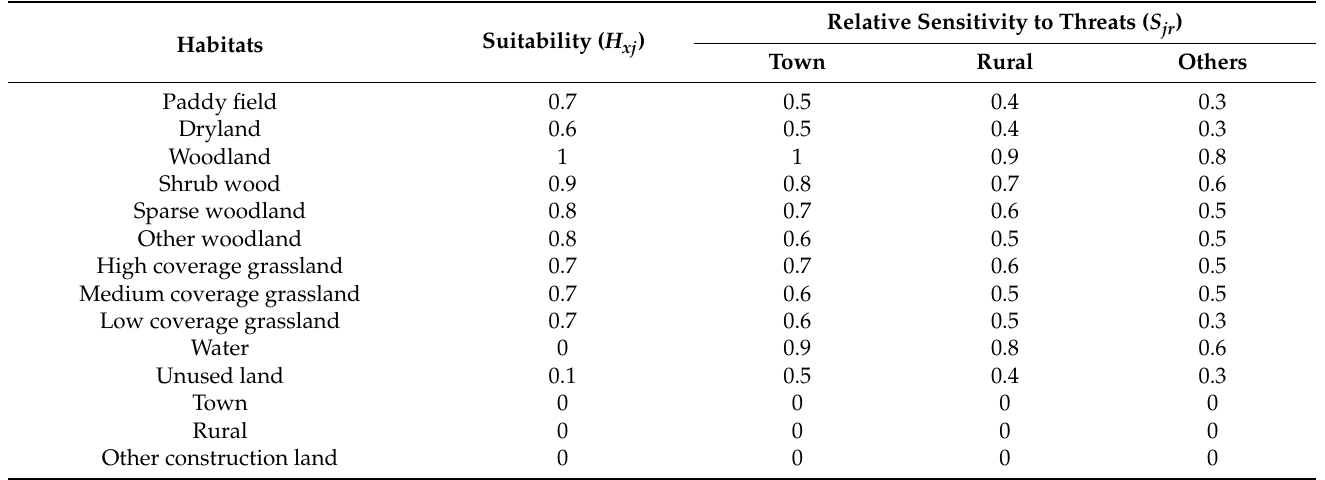
Table A1. Habitat suitability of terrestrial ecosystem and relative sensitivity to